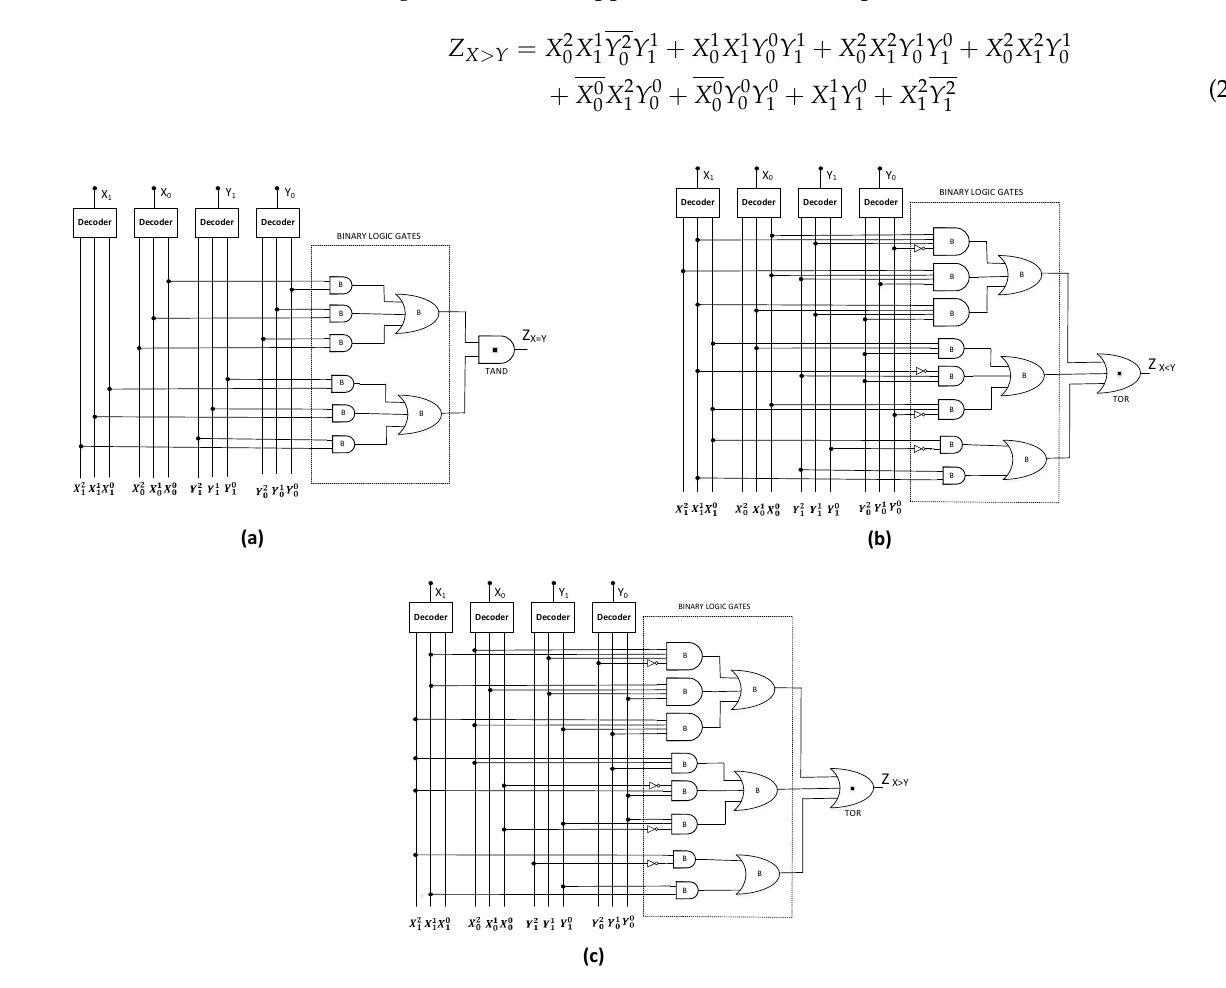
Figure 12. Schematic of ternary comparator. ( a ) X = Y, ( b ) X < Y, ( c ) X >